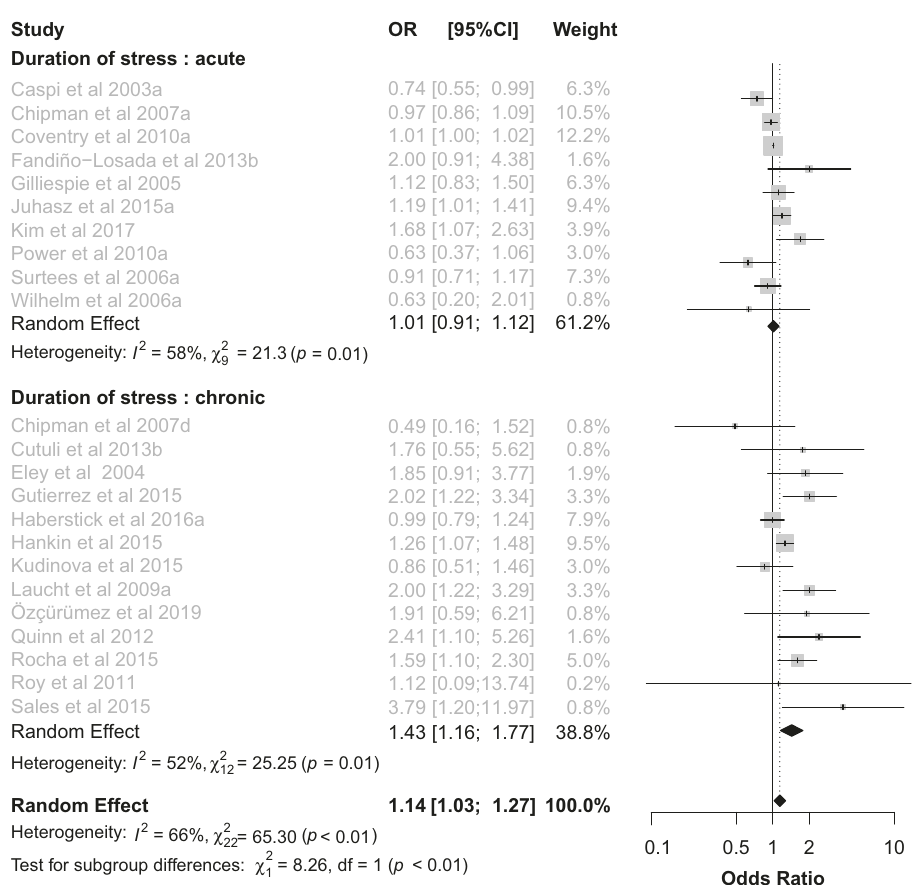
Fig. 2 The duration of stress affects the 5-HTTLPR x stress interaction. Forest plot (OR and 95% CI) for 22 studies assessing the relationship between 5-HTTLPR, stress and depression strati fi ed by duration of stress, chronic vs. acute. The area of each square is proportional to the study weight in the analysis. The diamond represents pooled estimates from random-effects meta-analysis. Dashed line represents the overall effect. OR Odds Ratio, CI con fi dence yielding 23 effect sizes, totaling 27,383 participants). There was moderate heterogeneity between studies ( I 2 = 66%, χ 2 = 65.30, p < 0.0001, Fig. 2). Duration of stress (chronic vs. acute) When stratifying studies for duration of stress (i.e., chronic vs. acute), the effect of 5-HTTLPR on depressive outcome was statistically signi fi cant only in interaction with chronic, but not acute, stress (respectively, OR 1.43, 95% CI 1.16 – 1.77, p < 0.001, I 2 = 52%, χ 2 = 25.25, p = 0.01 and OR 1.01, 95% CI 0.91 – 1.12, p = 0.81, I 2 = 58%, χ 2 = 21.3, p = 0.01; Fig. 2). The interaction test con fi rmed a subgroup difference ( p = 0.004), meaning that the duration of stress signi fi cantly affects the effect of the 5-HTTLPR x stress interaction. The sensitivity analysis con fi rmed a signi fi cant 5-HTTLPR x stress effect on depressive outcome in the subgroup of studies on chronic stress only (OR 1.17, 95% CI 1.01 – 1.34, p = 0.03, I 2 = 60%, χ 2 = 35.09, p = 0.001), despite the subgroup difference failed to reach statistical signi fi cance ( p = 0.13; Supple- mentary Table 3).